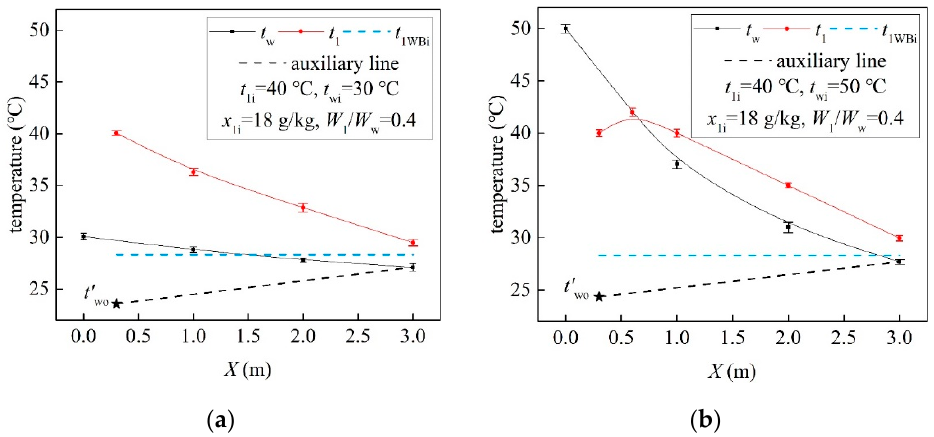
Figure 5. Temperature profiles under different inlet water temperatures: ( a ) t wi = 30 °C; ( b ) t wi = 50 °C.